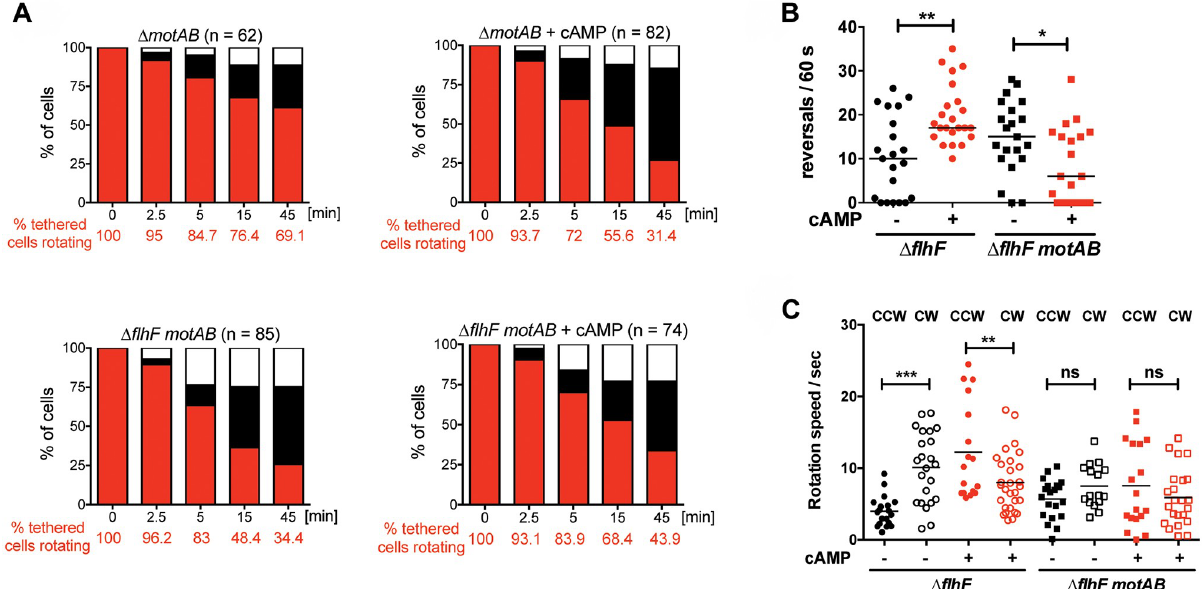
Fig 10. The MotAB stator is required for tethered bacteria to stop rotating. Bacteria were incubated with anti-flagellin antibody coated slides for 5 min in the presence or absence of 20 mM cAMP. (A) Behavior of tethered bacteria over time . Videomicroscopy was used to identify bacteria rotating at t = 0, and the behavior of these cells was followed for 45 min. The proportion of rotating cells (red), attached cells (black), and detached cells (white) was determined in 4–8 independent experiments. To compare the percentage of tethered cells that were rotating in presence or absence of cAMP, survival curves were analyzed with a Mantel-Cox test. Exogenous cAMP had a significant effect on PAK Δ motAB ( ��� , p = 0.0005), but not on PAK Δ flhF Δ motAB (ns, p = 0.0916). (B) Reversal frequency of tethered bacteria . Movies of tethered bacteria imaged at 100 fps for 60s were analyzed by a custom Matlab script to determine reversal frequency. Each symbol indicates reversals made by an individual cell over 60s (n = 21–23); lines indicate medians. cAMP increases the reversal frequency of Δ flhF , but decreases reversal frequency of the Δ flhF motAB mutant (Kruskal-Wallis with Dunn’s multiple comparison test; � , p < 0.05; �� , p < 0.01). (C) Rotation speeds of tethered bacteria . CW and CCW rotation speeds were extracted from tethered bacteria analyzed in panel